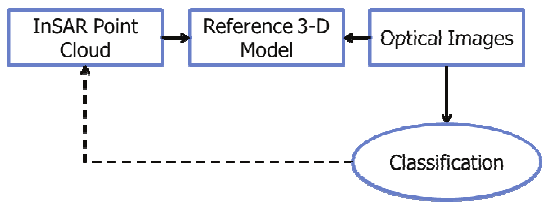
Figure 1. Flowchart of the proposed method. The semantic classification of the InSAR point cloud is achieved by co- registering the InSAR point cloud and the optical image to a reference model.